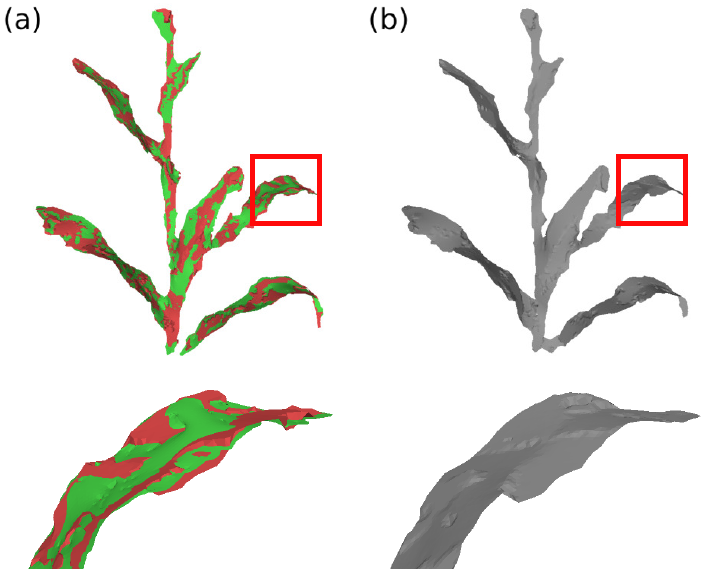
Figure 13. Input and model surfaces fusion. ( a ) Overlap of the deformed model surface (green) and the input surface (red) and ( b ) new model after surfaces